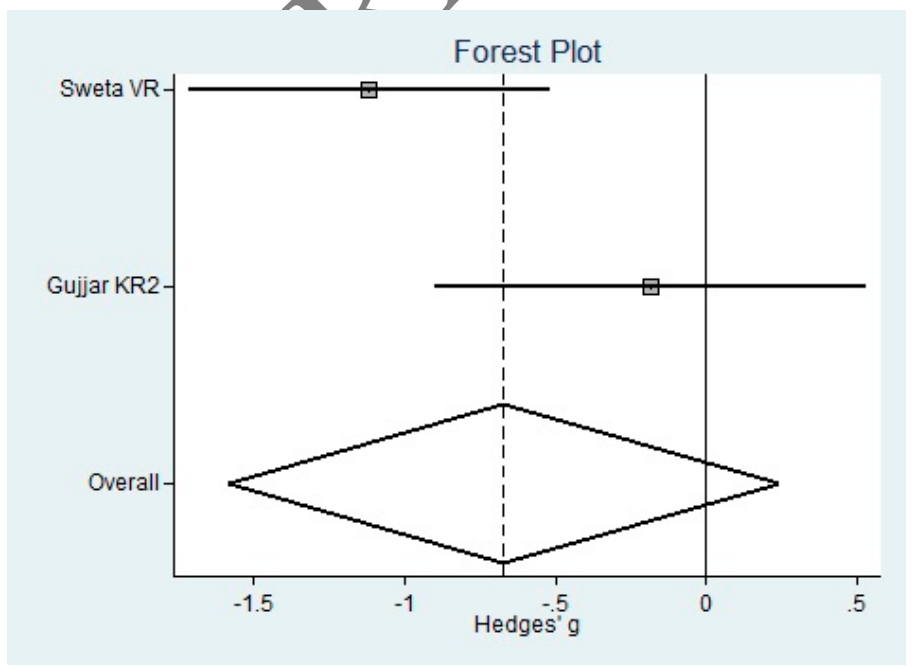
Figure 7. Forest plot for Pain in Adults.